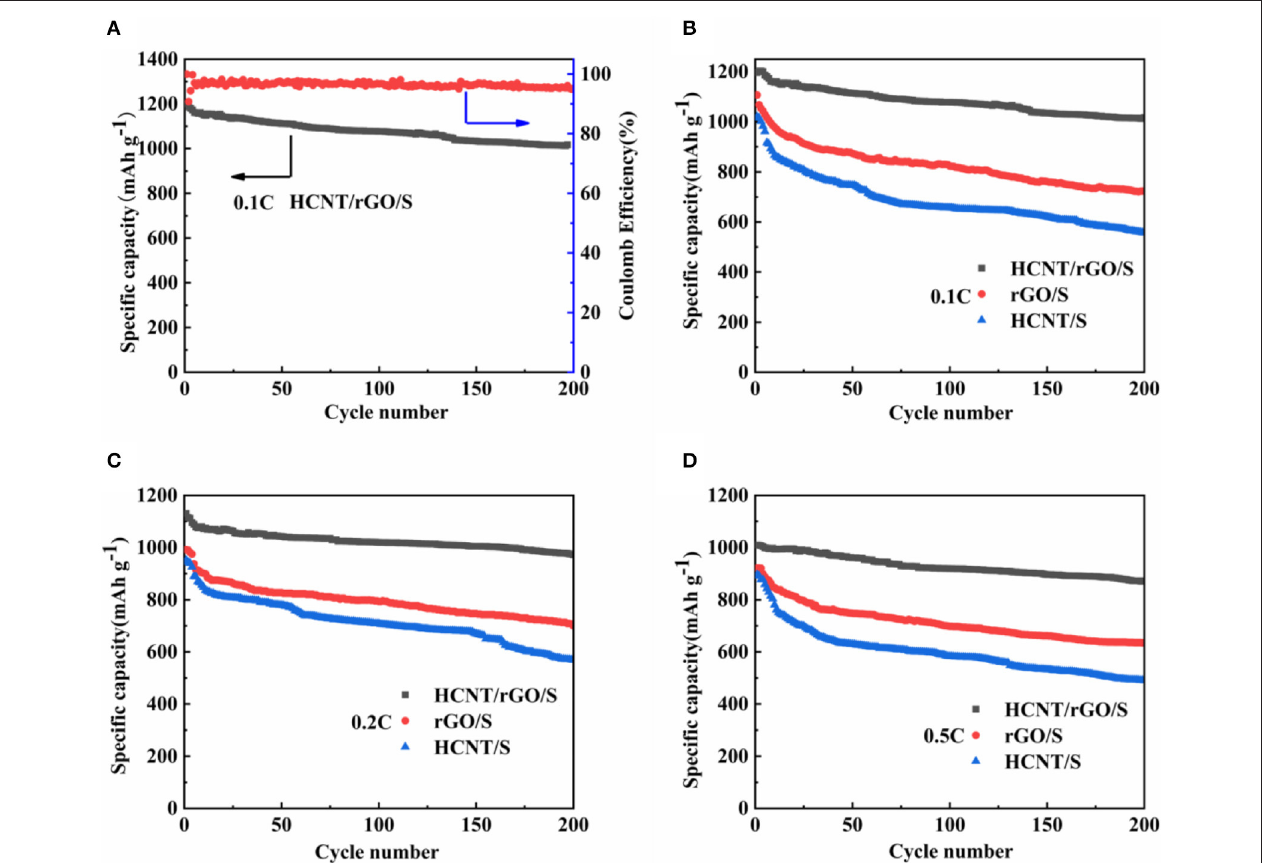
FIGURE 6 | Cycle performance of Li-S cells (A) 0.1C, (B) 0.1C, (C) 0.2C, (D) 0.5C.